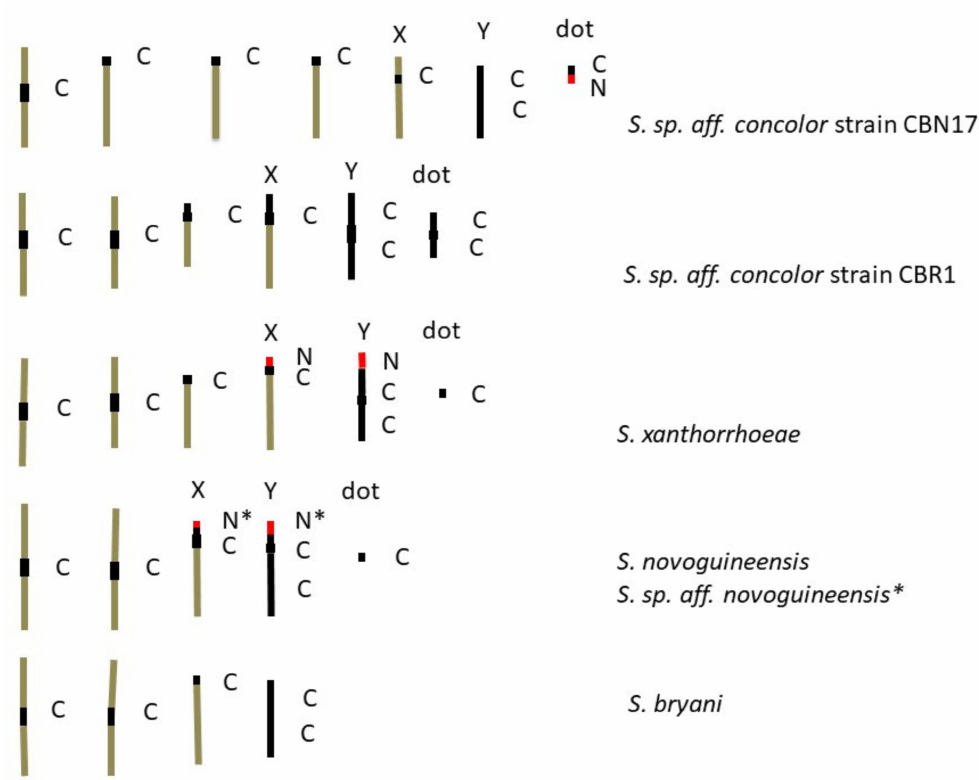
Figure 8. Ideograms of chromosomes examined. C = C-banded heterochromatic region; N = NOR location by FISH; ?N = possible NOR (FISH not conducted for male); Nsat = NOR identified by satellite location; N* = FISH conducted for S. sp aff .